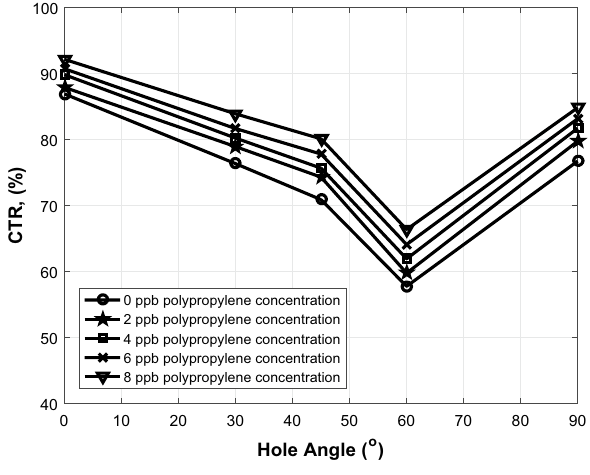
Fig. 6 Cutting transport ratio vs. hole angle for cuttings size of